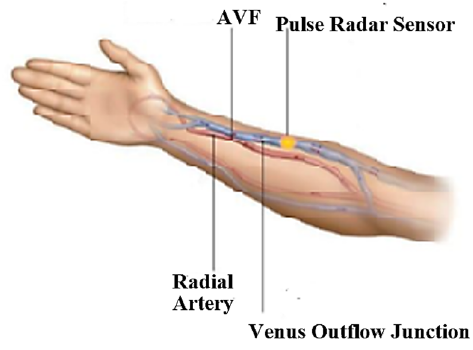
Figure A2. The pulse radar sensor.